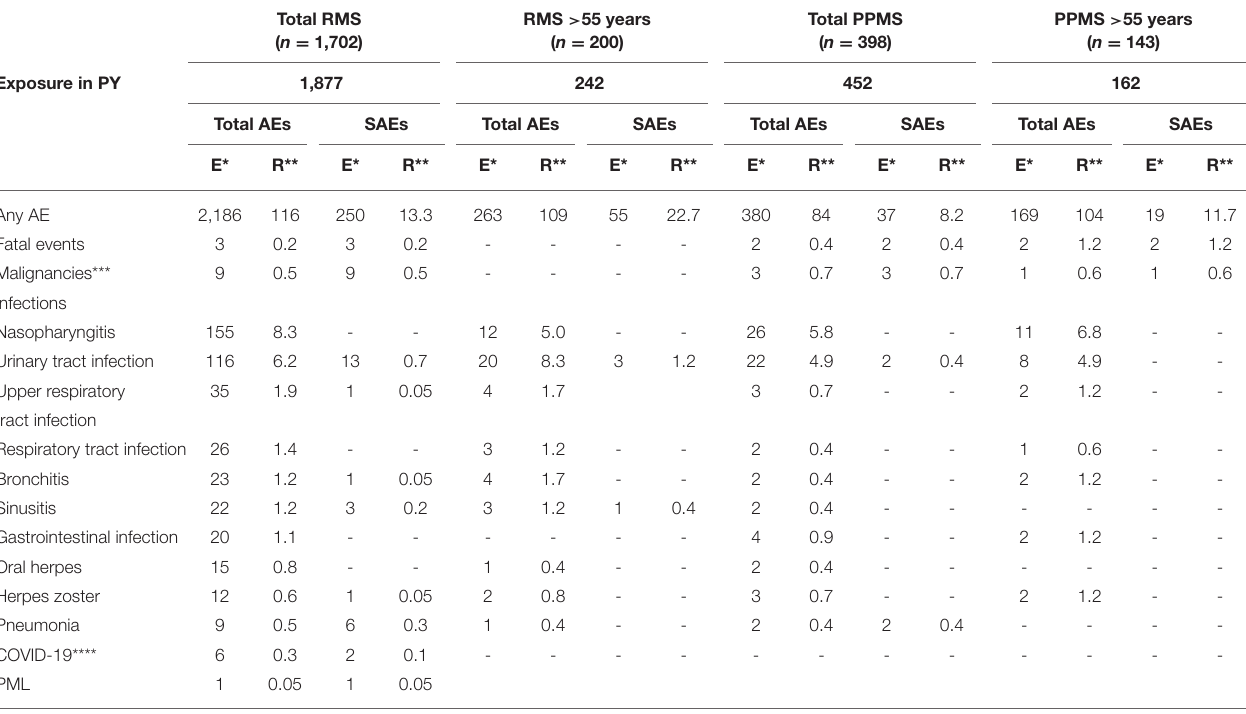
Total RMS ( n = 1,702)